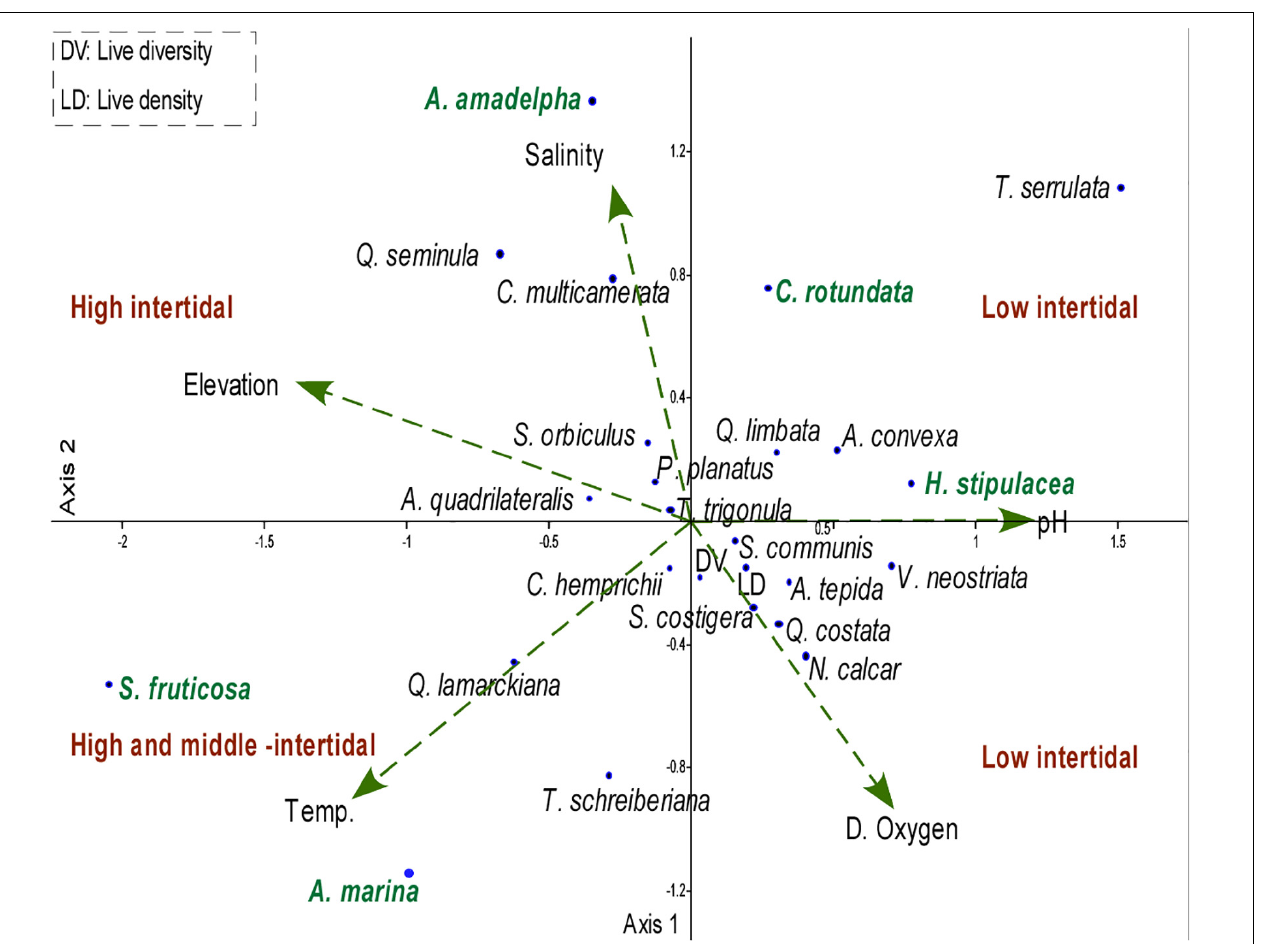
was recorded in the intertidal zone above 0.2 m